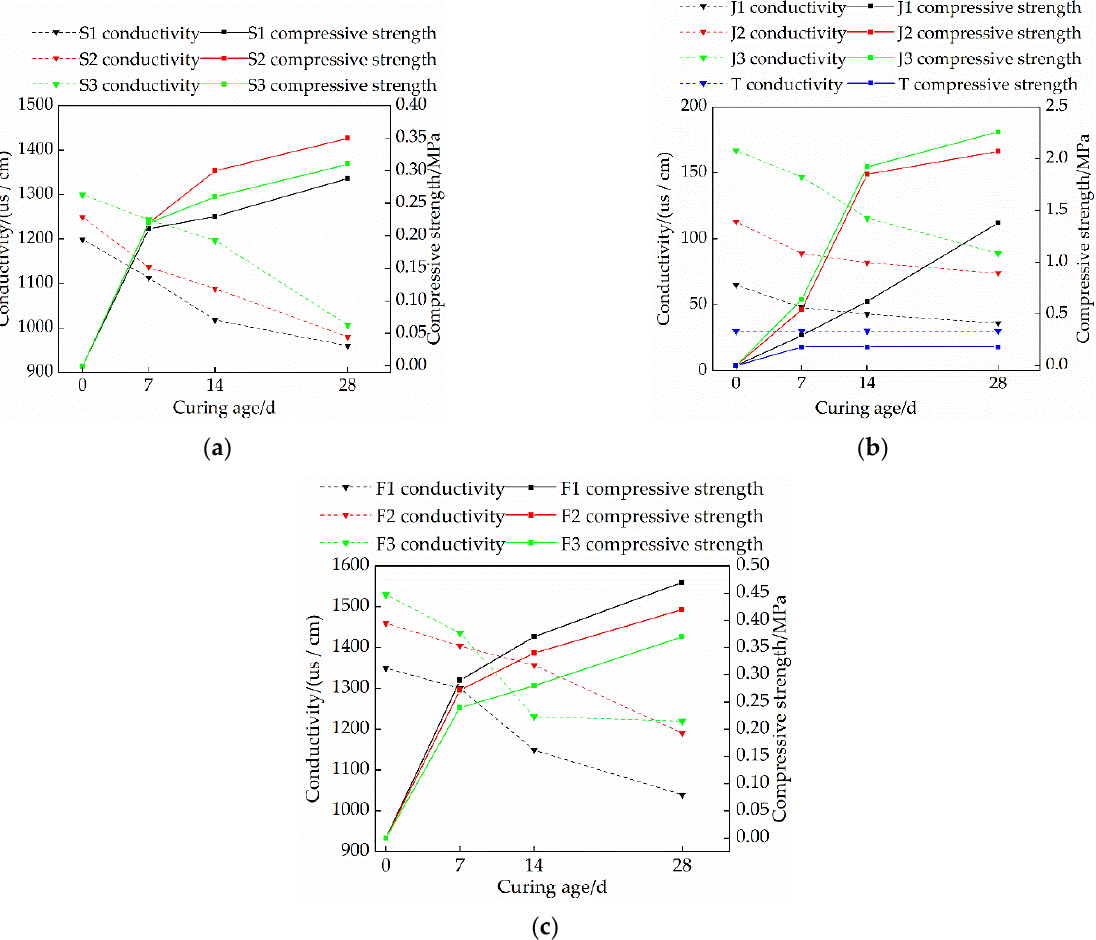
Figure 10. Variation of sample conductivity with curing age: ( a ) Single lime mixed group; ( b ) Mono- doped sodium methyl silicate group; ( c ) Compounding group .